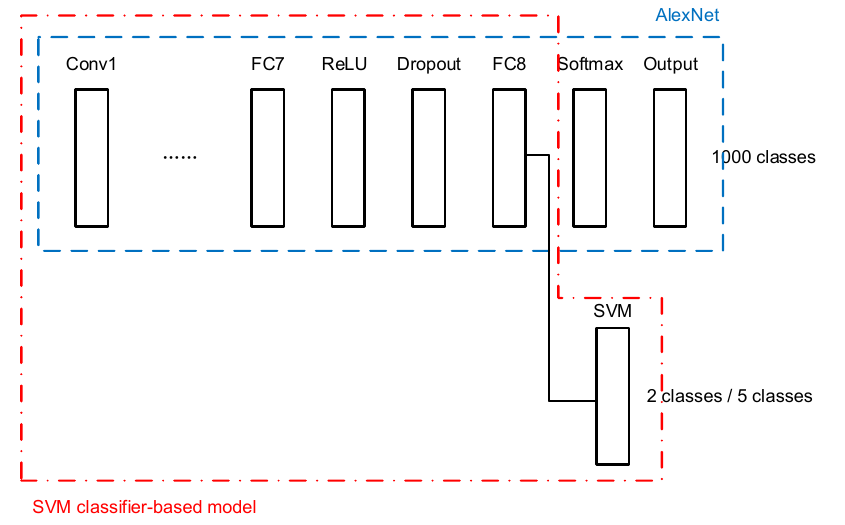
Figure 5. SVM classifier-based model.